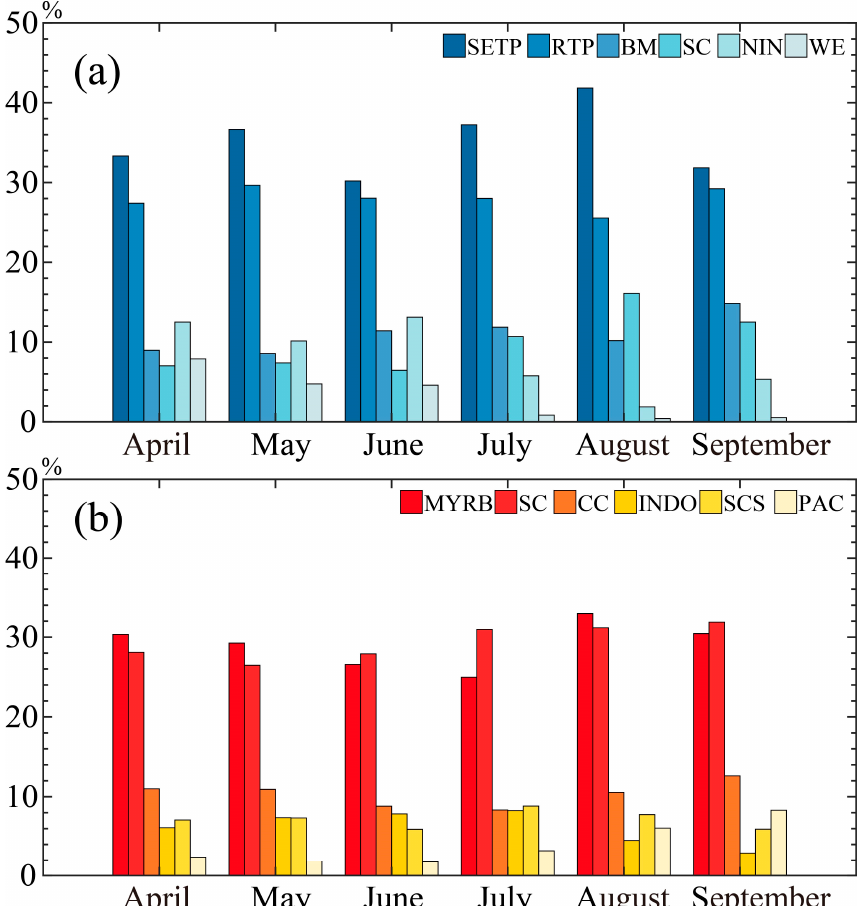
Figure 2. Monthly variations of the top six evaporative sources of precipitation in the ( a ) SETP and the ( b ) MYRB in the wet season, averaged over 1982–2011. The monthly evaporative source percentage for each sub-region is the contribution of the evaporative source in the sub-region to the precipitation in the target region.